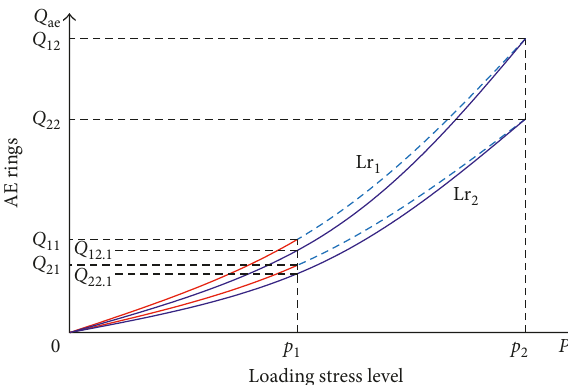
Figure 13: Growth model of rock AE rings under low and high loading